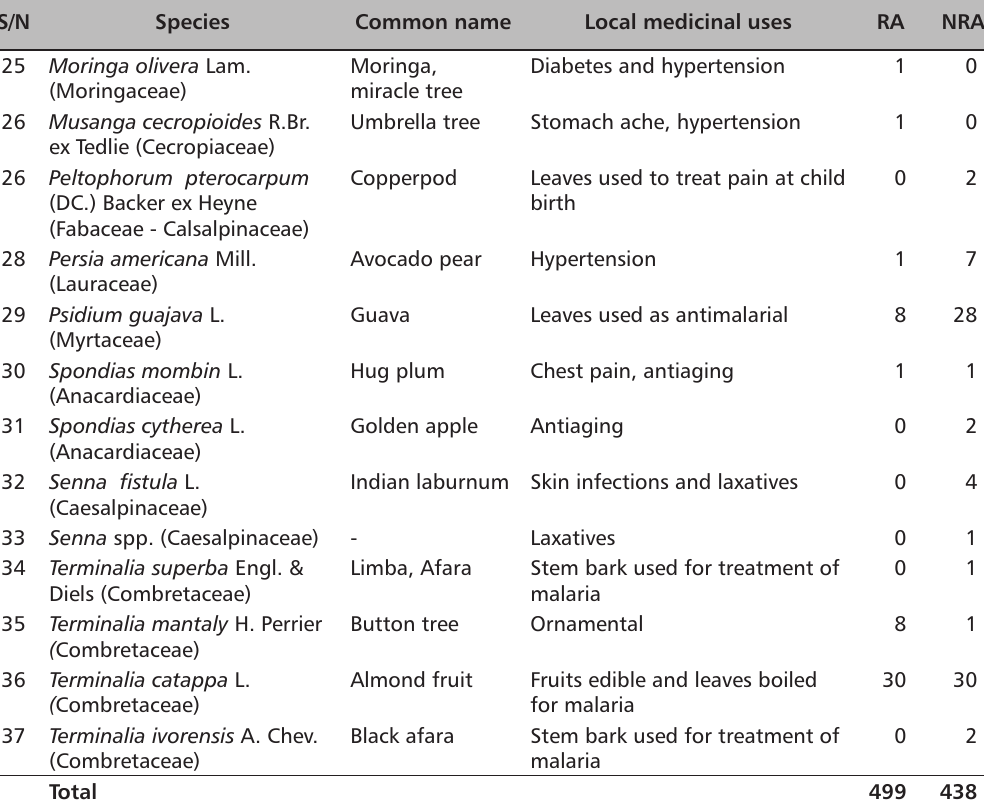
TABLE 1. Species composition and richness of ethno-medicinal tree - continuation